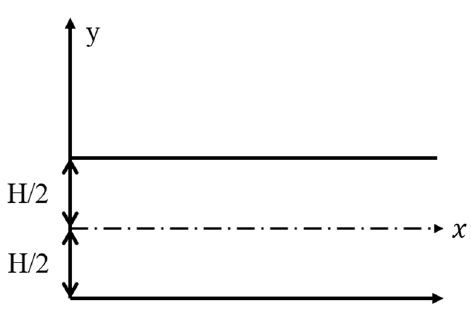
Figure 1. Schematic geometry of a free plate problem with regard to the Lamb wave.